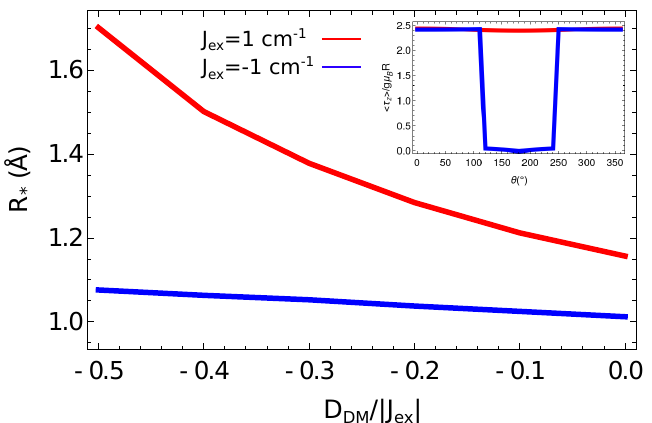
Figure 7. Critical circumscribed radius R ∗ at which toroidal ground states manifest in five-membered on-site S = 1/2 molecular wheels as function of Dzyaloshinskii–Moriya coupling strength D DM in Heisenberg rings with ferromagnetic (red) and antiferromagnetic (blue) isotropic exchange coupling. Inset shows the dependence of the ground-state toroidal moment on the orientation of the D DM vector for a 5-membered S = 1/2 ring with | J ex | / R = 1 cm − 1 Å − 1 and D DM / | J ex | = − 0.1 with ferromagnetic (red) and antiferromagnetic (blue) isotropic exchange